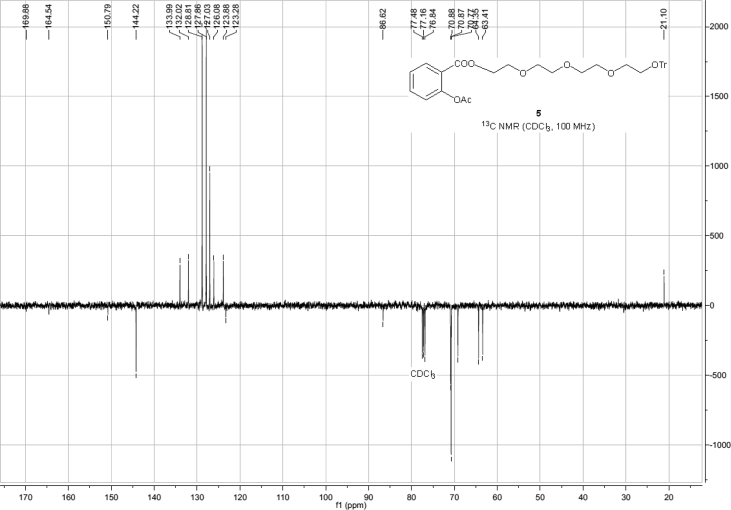
13C NMR spectra of compound 5.